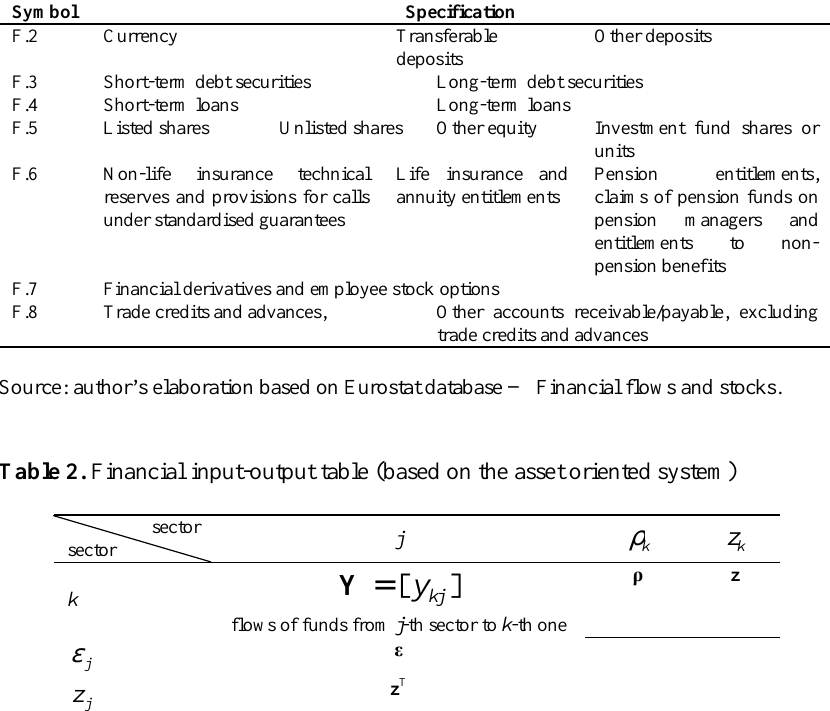
Table 1. List of financial instruments recorded as assets of households' in the